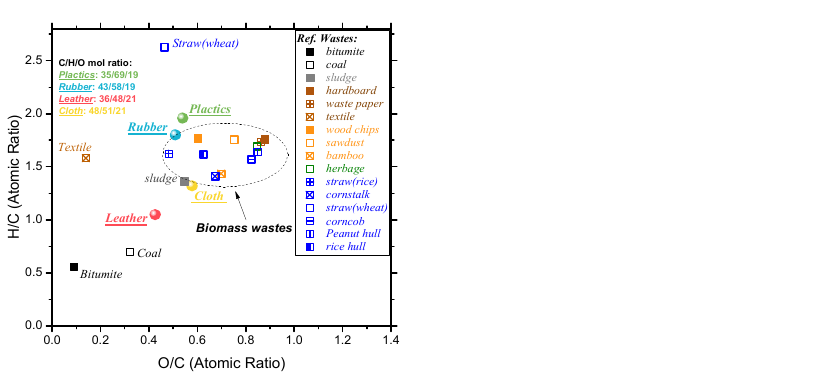
Figure 1. Van Krevelen plot of four polymeric wastes and the other compared fuels.